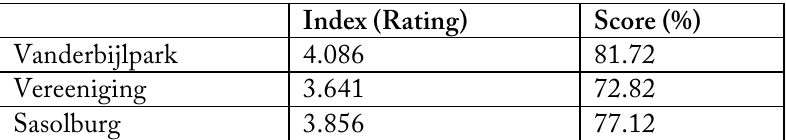
Table 6 Environment component